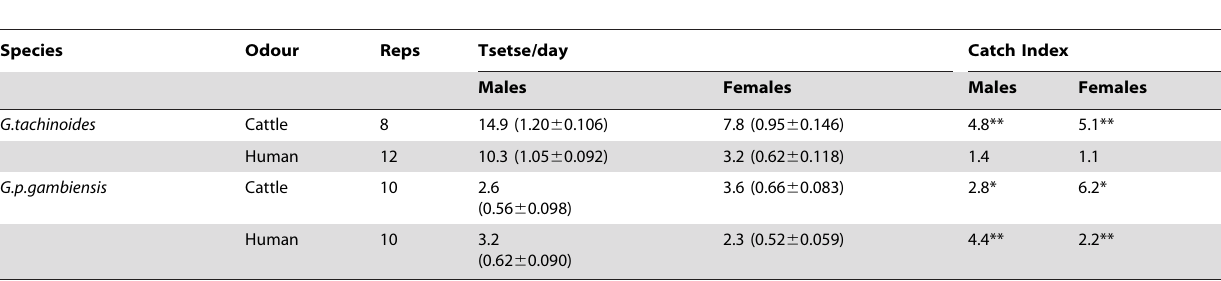
odour-baited traps expressed as a proportion (Catch Index) of that from an unbaited trap.